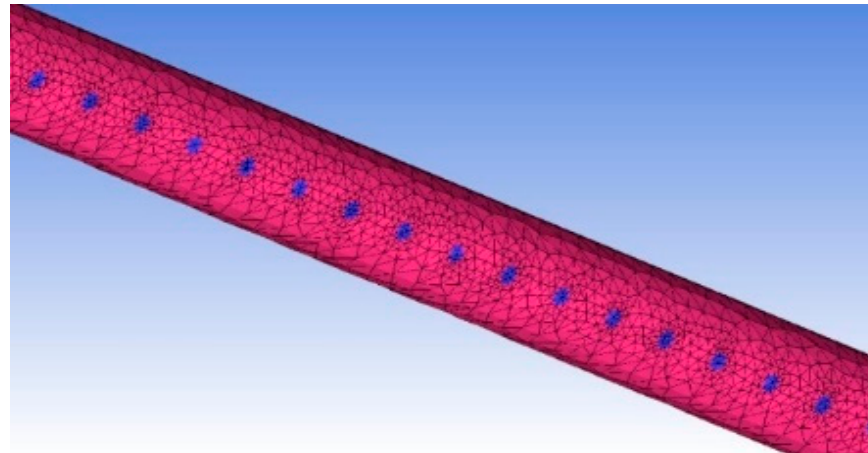
Figure 4. Grid distribution of outlet pipe and bottom outlet. Figure 3. Inlet pipe grid distribution Figure 3. Inlet pipe grid distribution diagram. Figure 3. Inlet pipe grid distribution diagram.